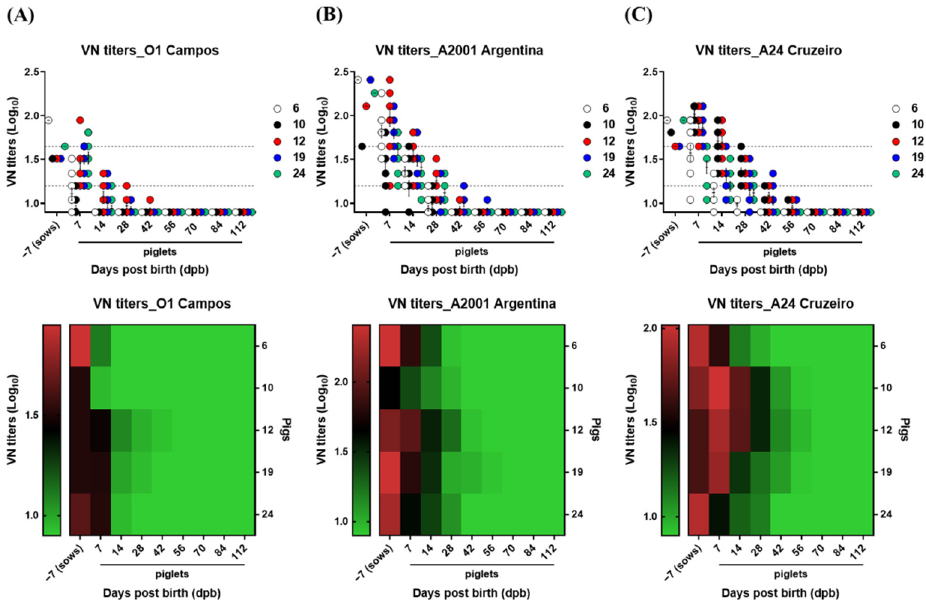
Figure 2. Age-dependent dynamics of maternally derived VN titers for O1 Campos, A2001 Argentina, and A24 Cruzeiro in the serum of sows and piglets. To understand the properties of maternally derived antibodies (MDAs), five sows and 10 piglets from each sow were screened. For sows, blood was collected 7 days before farrowing. For piglets born to sows, blood was collected on 7, 14, 28, 42, 56, 84, and 112 days post-birth. The virus-neutralizing antibody (VN) titer for O1 Campos, A2001 Argentina, and A24 Cruzeiro was measured in sampled serum. The black dotted line represents VN titers of 1.65 Log 10 or 1.2 Log 10 . Data are presented as the mean ± SEM of triplicate measurements ( n = 5 for sows and 10 piglets/sow). Figures were presented as scatter plots and heat maps. ( A – C ) rep- resent: ( A ) VN titers for O1 Campos; ( B ) VN titers for A2001 Argentina; ( C ) VN titers for A24 Cru- zerio.